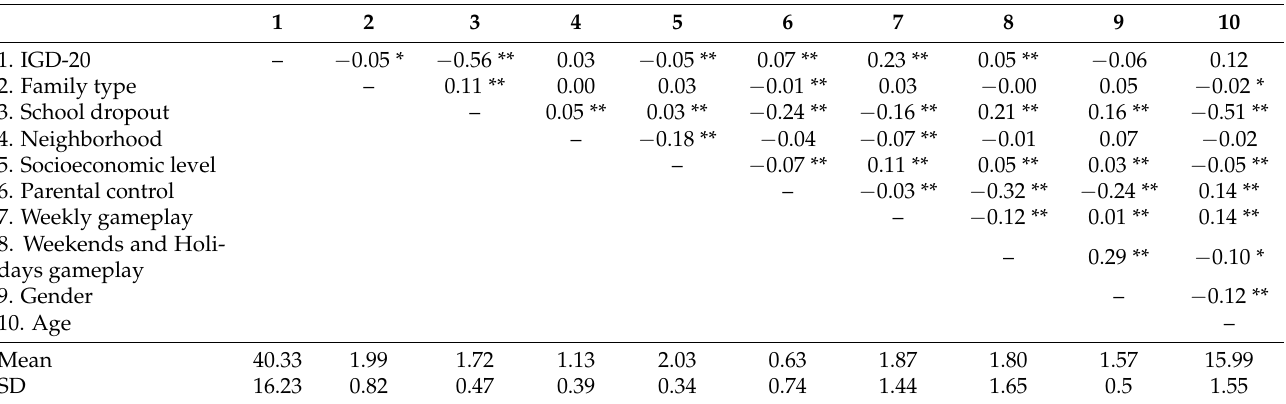
Table 5. Concurrent and convergent validity of the IGD-20